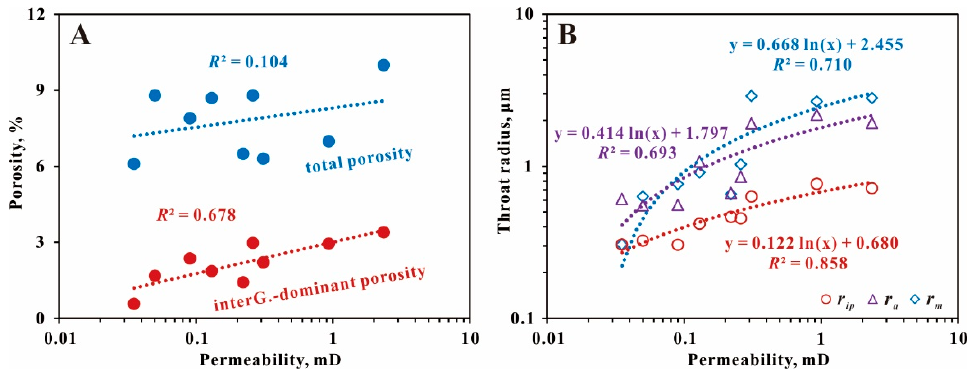
Figure 19. Correlations between permeability and porosity ( A ) and throat radius ( B ) parameters. InterG.-dominant = intergranular-dominant.